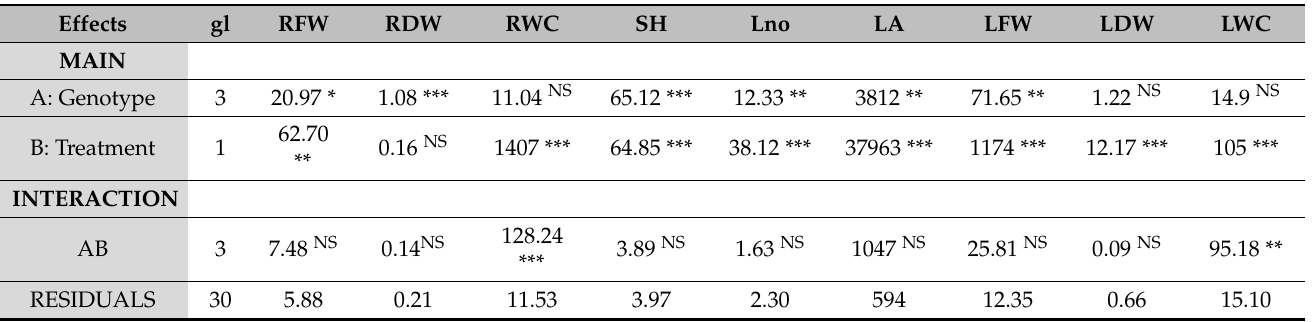
Table 1. Analysis of variance for growth parameters measured in control and water-stressed plants of parental genotypes. The values shown represent the mean square of the following parameters: root fresh weight (RFW), root dry weight (RDW), root water content (RWC), stem height (SH), leaf number (Lno), leaf area (LA), leaf fresh weight (LFW), leaf dry weight (LDW), and leaf water content